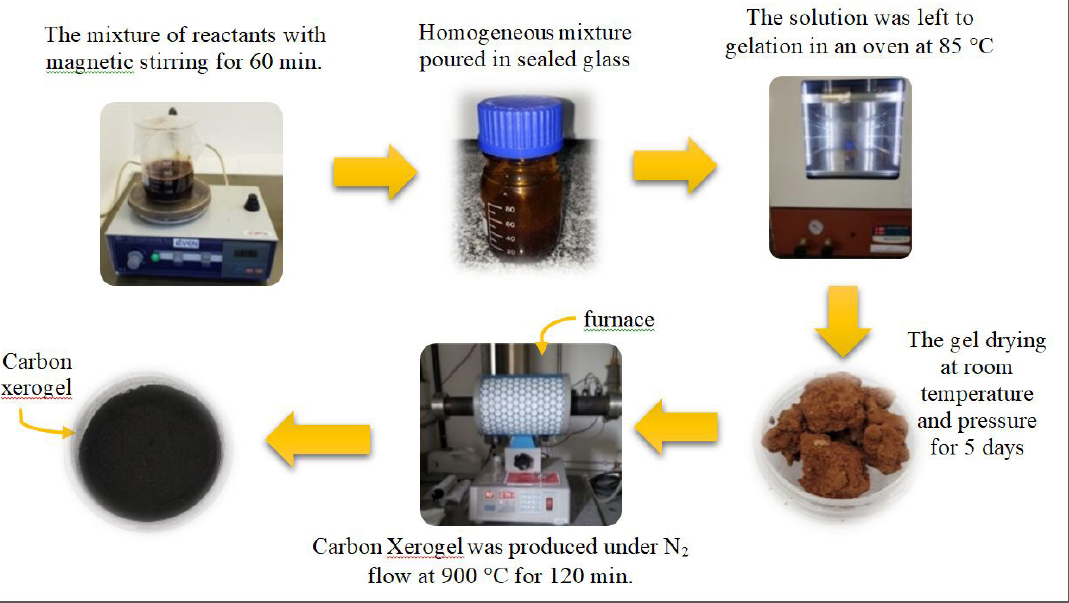
Figure 1. Production of the carbon